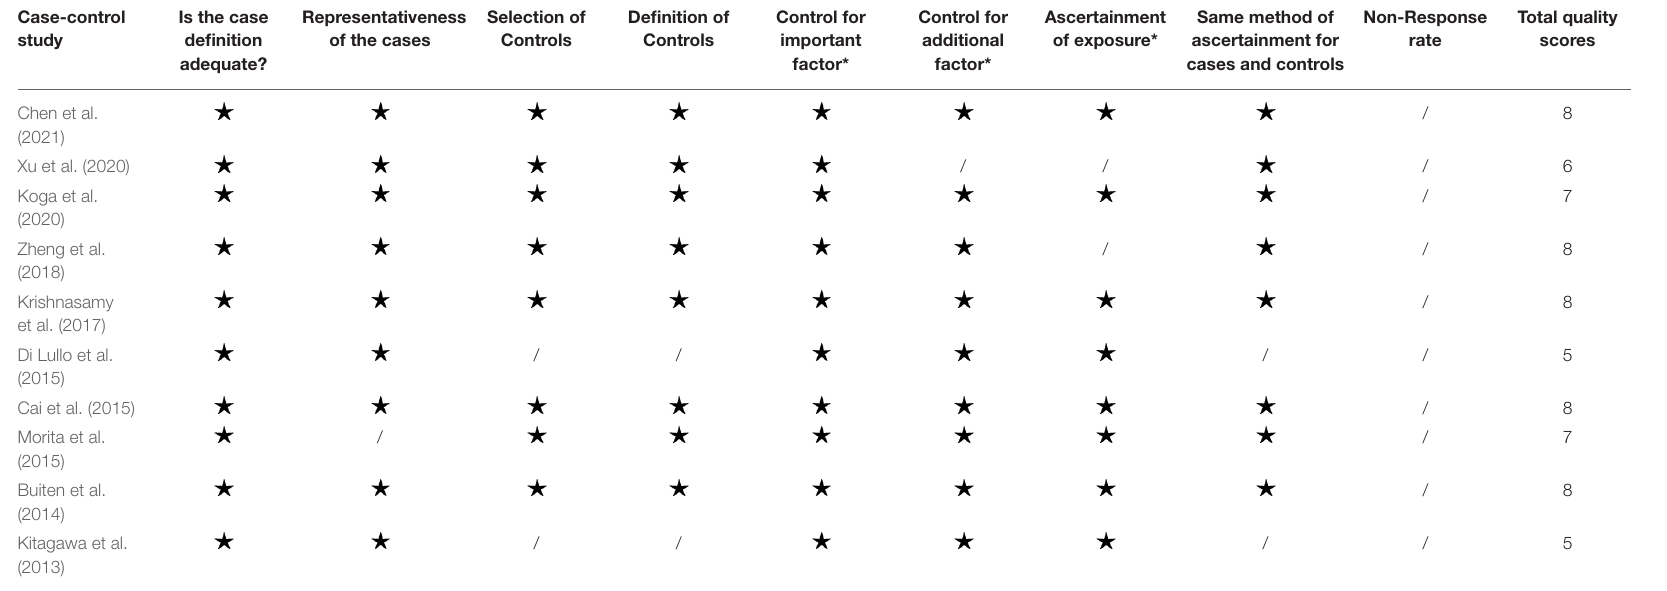
TABLE 2 | NOS scores of the case-control studies